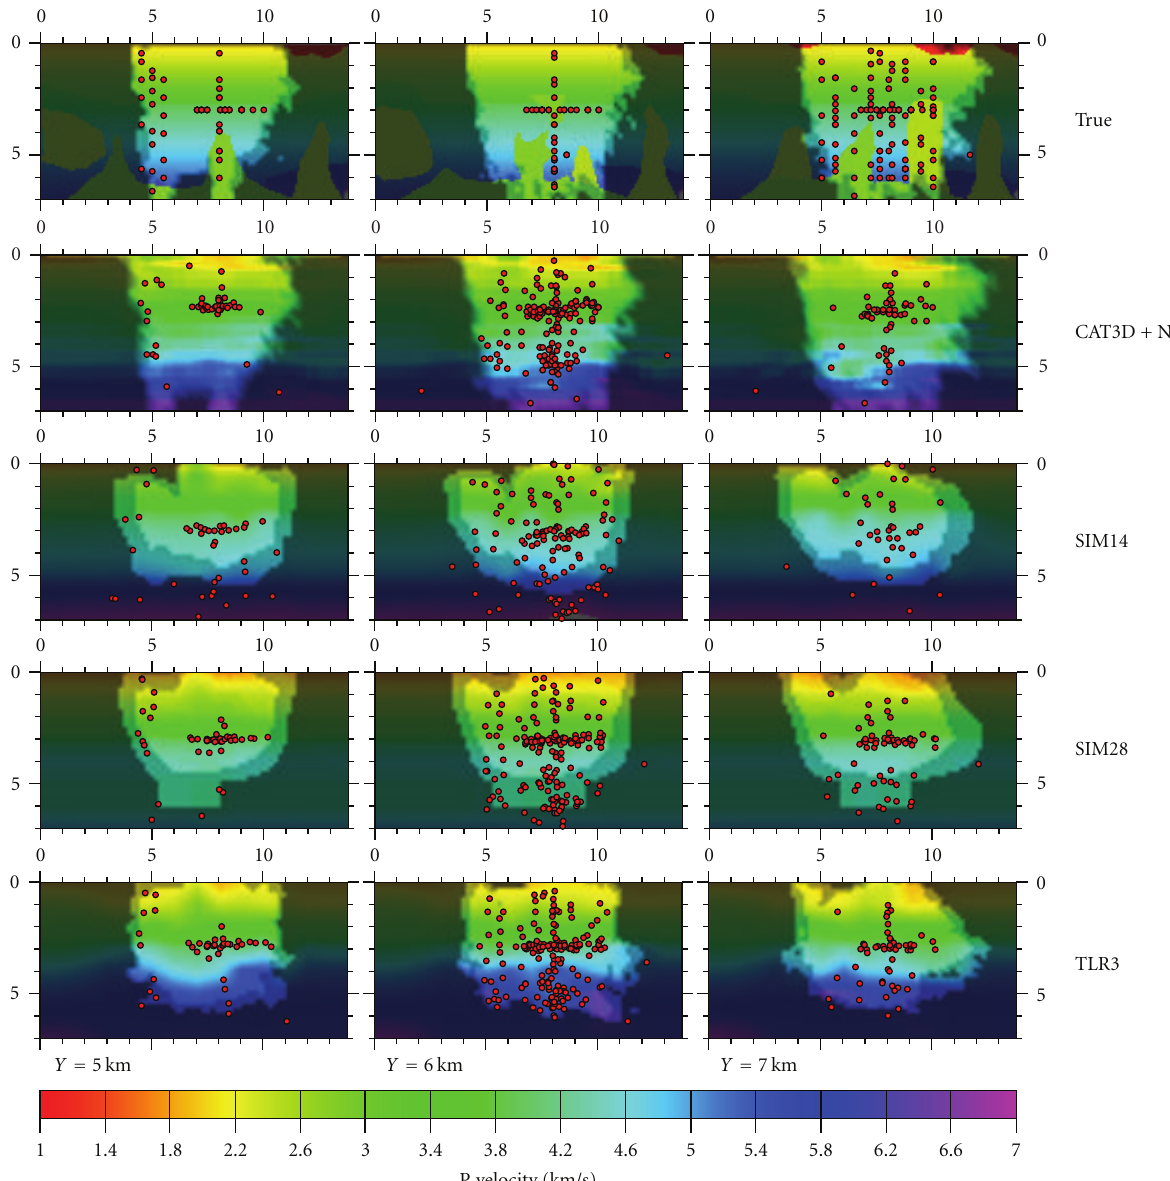
Figure 16: V P fields obtained by the di ff erent methods along vertical EW sections at Y = 5,6,7 km. The red dots represent the sources localized by each method near each section. Inverted models are masked by the resolution matrices that correspond to each method. See text for more